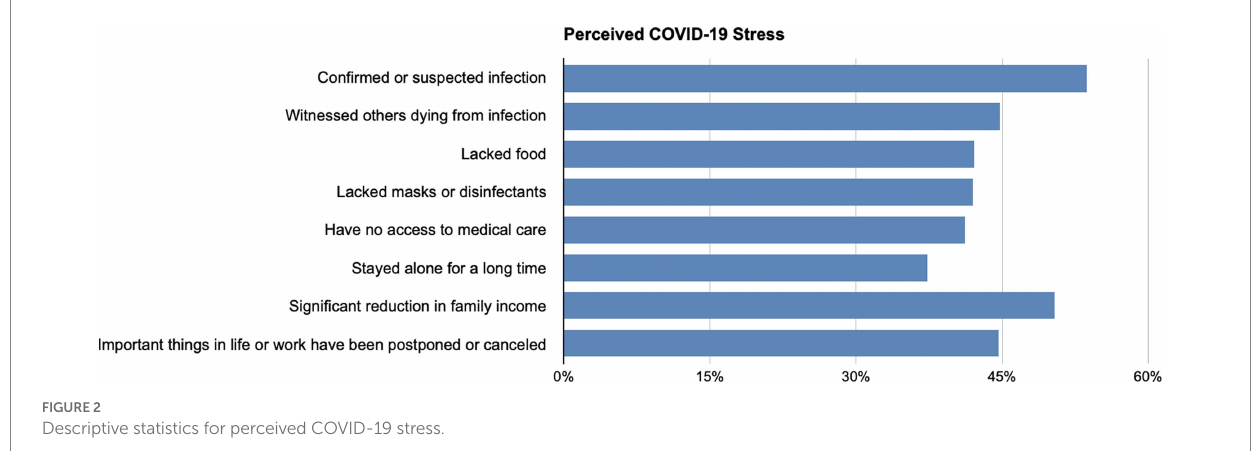
FIGURE 2 Descriptive statistics for perceived COVID-19 stress.